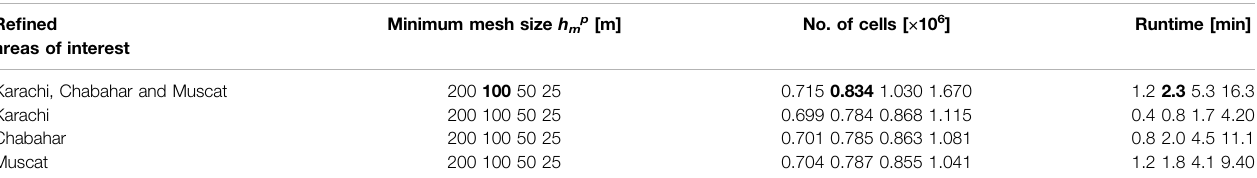
TABLE 2 | Runtimes using one Nvidia Tesla V100 GPU for the 6 h simulations with various mesh con fi gurations. Text highlighted in bold refers to the chosen mesh set up used for this study ( Figure 5 ). Re fi ned areas of interest